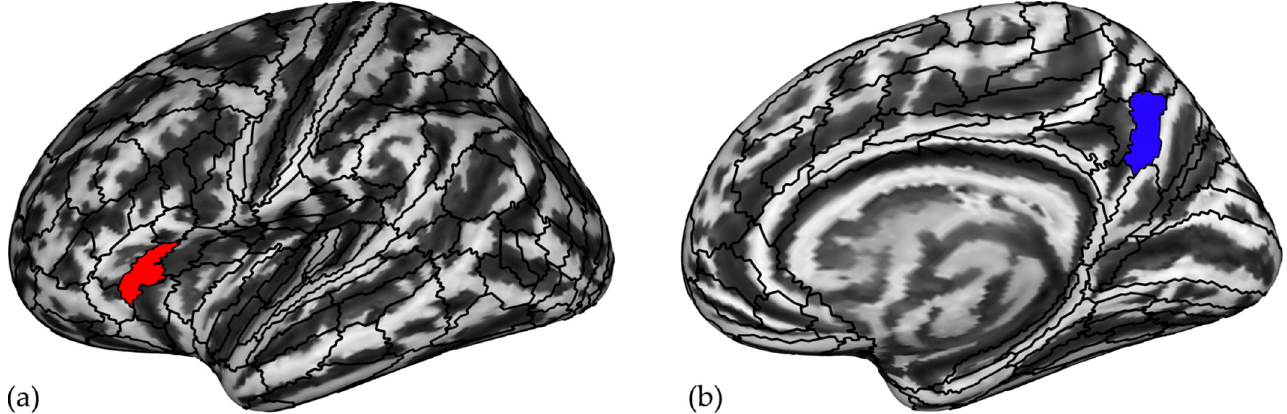
Figure 4. Increased gyrification index in ( a ) the posterior part of the right anterior cingulate cortex (a24pr, in red) and decreased in ( b ) the superior and posterior part of the right superior temporal sulcus (STSdp, in blue) predicted chess expertise using logistic regression. R, right.